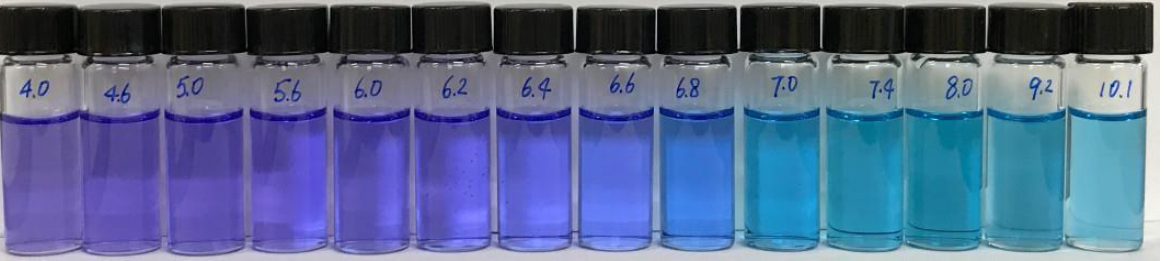
Figure 2. Photos of 10 µM probe + AH + in different pH PBS buffers where pH values were marked in the vials above.